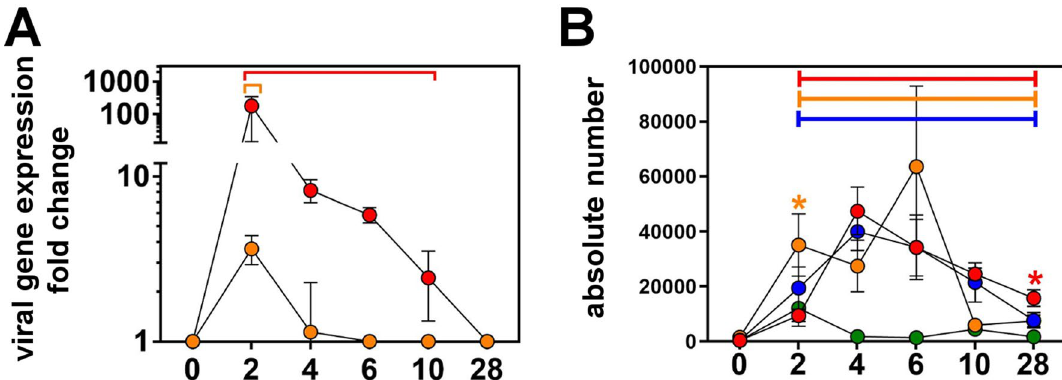
Figure 4. WT HSV-1 gene expression and immune infiltrate at the lip inoculation site. Naïve mice were infected in the lip with PBS (Mock; green), WT HSV-1, or TK del on day 0. Superinfection model mice were initially inoculated with TK del in the right lip on day -4 and then superinfected with WT HSV-1 on day 0 in the left lip. On different days for each group, thymidine kinase viral gene expression was measured by RT-qPCR in inoculation site lip tissue ( A ), while CD45 +ve cells were defined and absolute numbers enumerated from single cell suspensions by flow cytometry ( B ). Colored bars indicate significant differences from uninfected tissue at day 0 (permutation test, p < 0.01 ), while asterisks indicate significance between both unprimed WT HSV-1 and Mock (green) versus superinfection model ( orange ), or both superinfection model and PBS mock infection versus unprimed WT HSV-1 ( red ) ( p < 0.03; permutation test ). Each point represents n = 4 individual biological replicates. Figures were formulated using Flowjo, Excel and